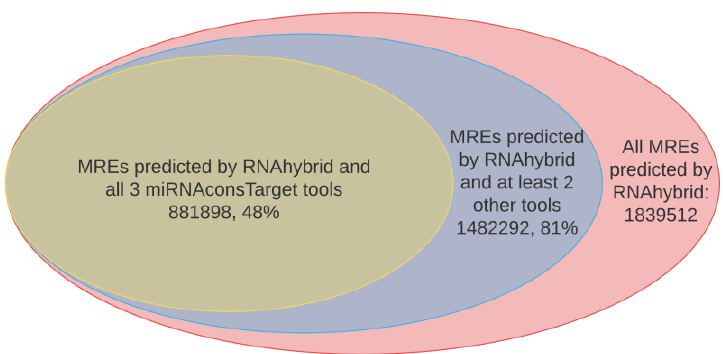
Figure 3. Number of MREs predicted by RNAhybrid (red), RNAhybrid and at least two other of the miRNAconsTarget tools (blue), or RNAhybrid and all three miRNAconsTarget tools (yellow). miRNAconsTarget tools (blue), or RNAhybrid and all three miRNAconsTarget tools